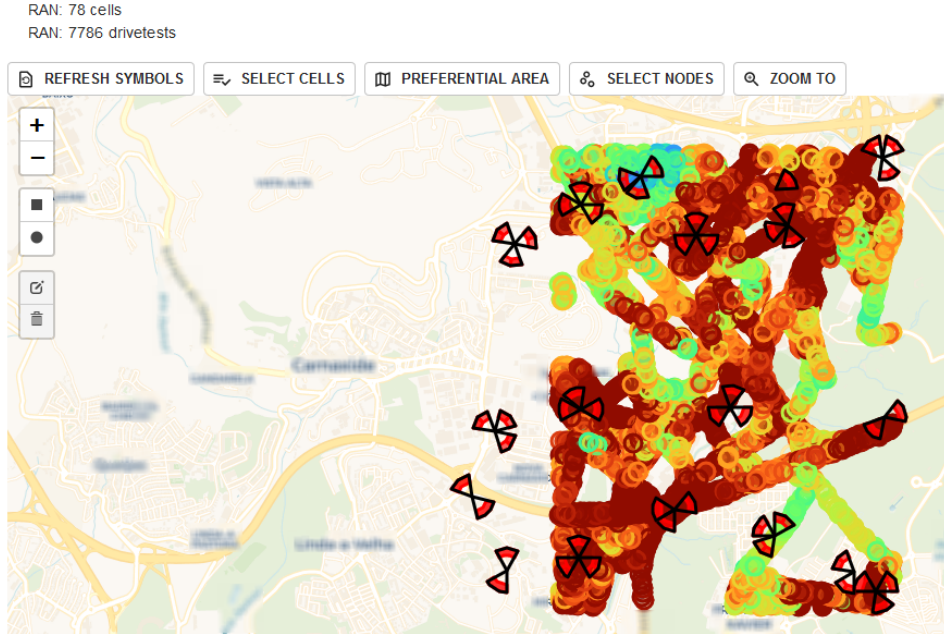
Figure 20. Lower carrier frequency coverage (DTs).